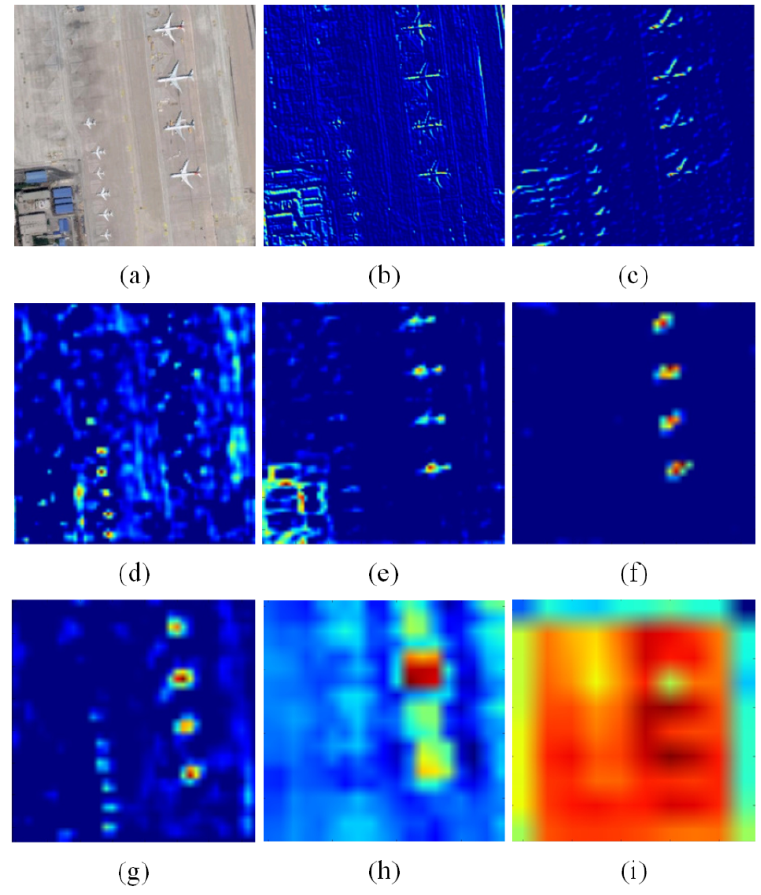
Figure 3. Heatmaps. ( a ) is an input image; ( b – d ) demonstrate the heatmaps collected from the forepart of the network; ( e – i ) show the heatmaps collected from latter layers of the